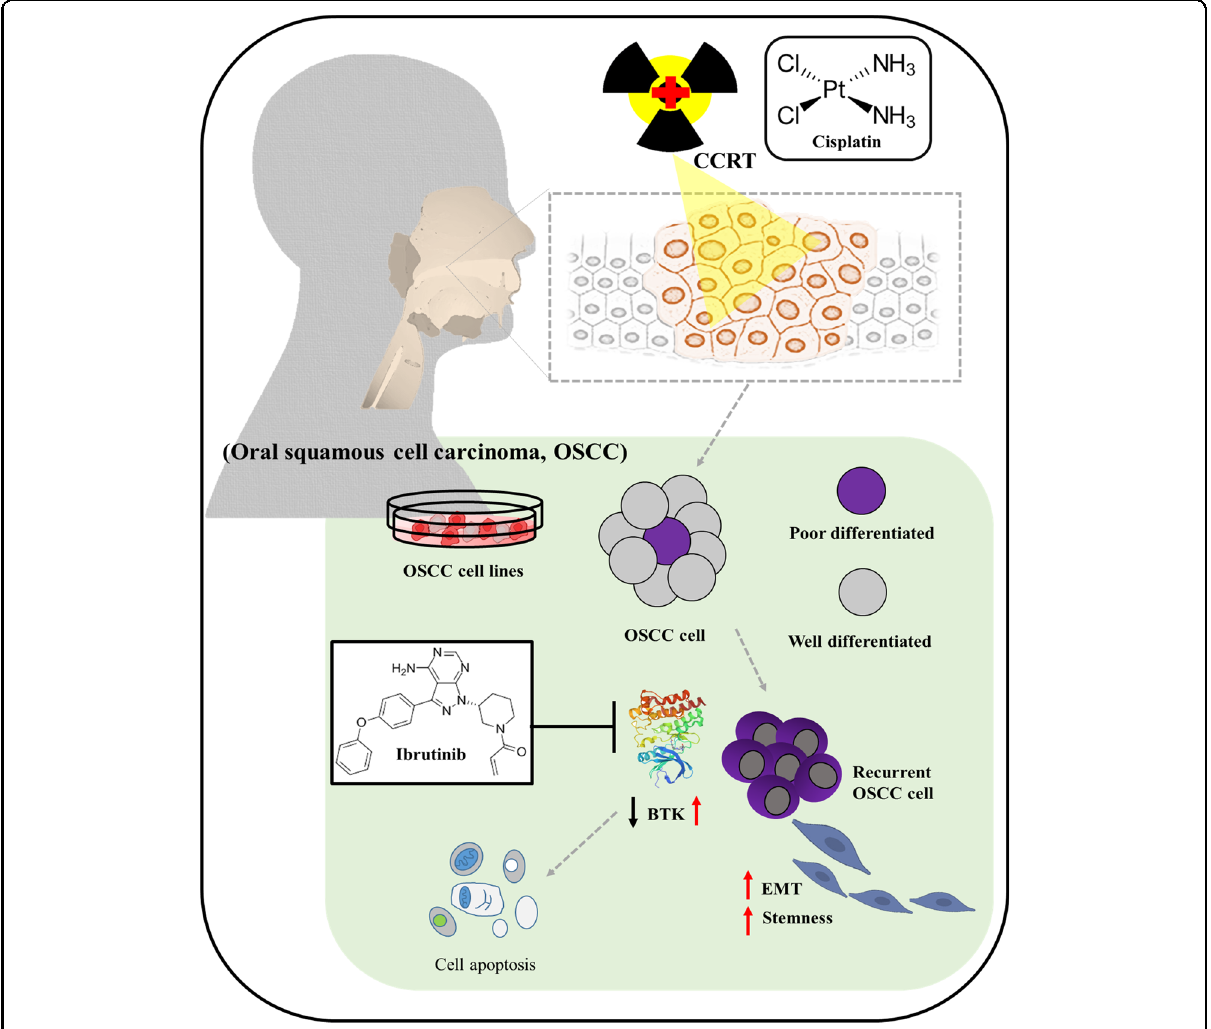
Fig. 7 Graphical abstract. A pictorial abstract showing BTK-related molecular network and how the suppression of the integrin-associated signal transducer BTK enhances radio- or chemosensitivity by downregulating CSCs-associated pluripotency factors and deactivating EMT in OSCC